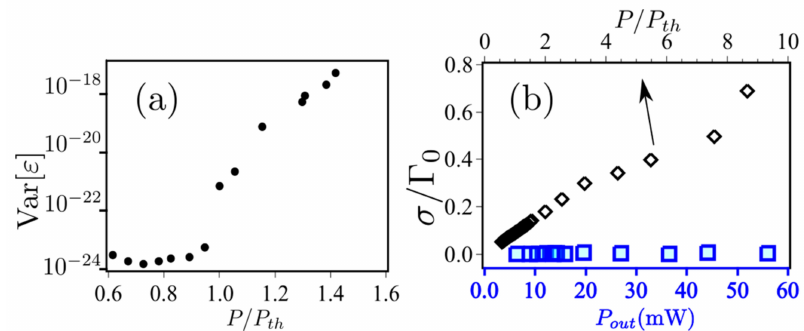
Figure 4. ( a ) Variance of the emitted intensity as a function of the normalized input power P/P th ; ( b ) Standard deviation of the maximum intensity (normalized by its average value) of the CW semiconductor pump laser (as function of the output power P out ; squares) and the Er-RFL system (as function of the normalized input power P/P th ; diamonds). (Reproduced with permission from ref.